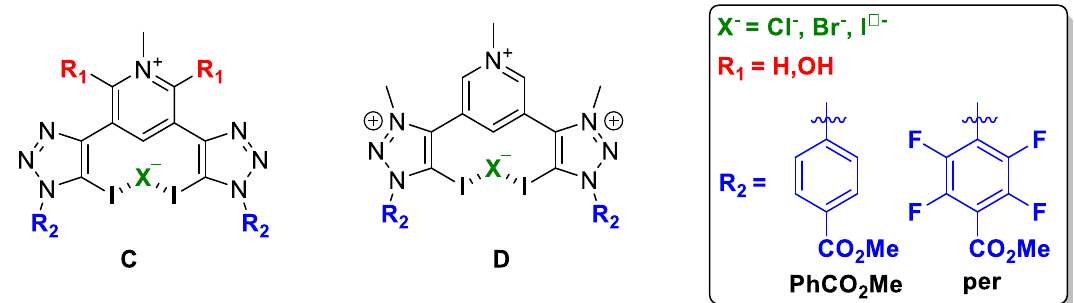
Figure 5. Schematic representation of the compound subject to study: ( C ) neutral XB donor motif and ( D ) cationic XB donor motif.